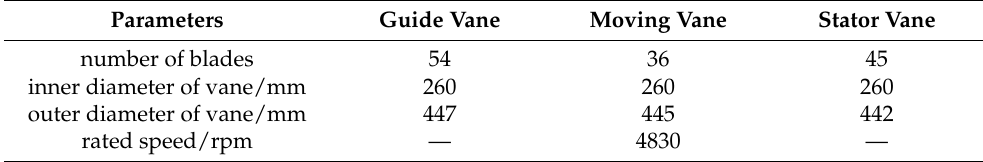
Table 1. Structure parameters of the 1.5-stage axial compressor. Parameters Guide Vane